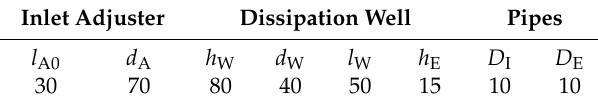
Figure 4. Detailed description of the dissipation well. Table 1. The value of constant parameters in the experiment (cm).